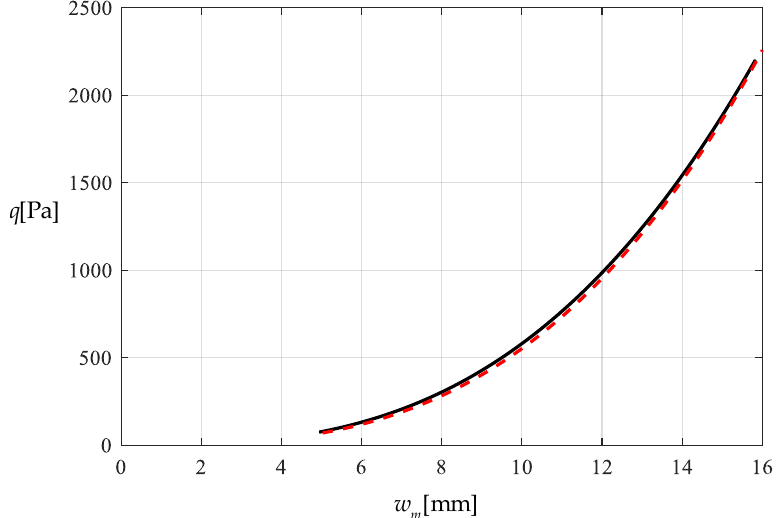
Figure 15. Variations of q with w m .